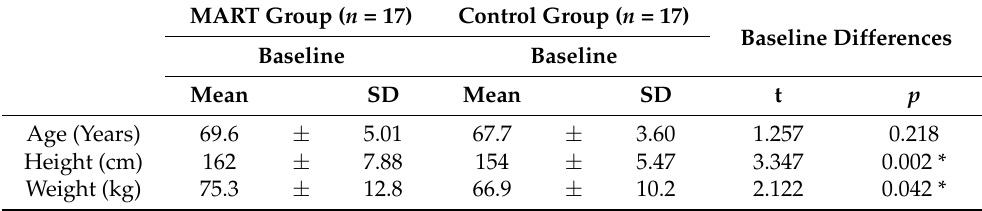
Table 1. Baseline characteristics of study participants.